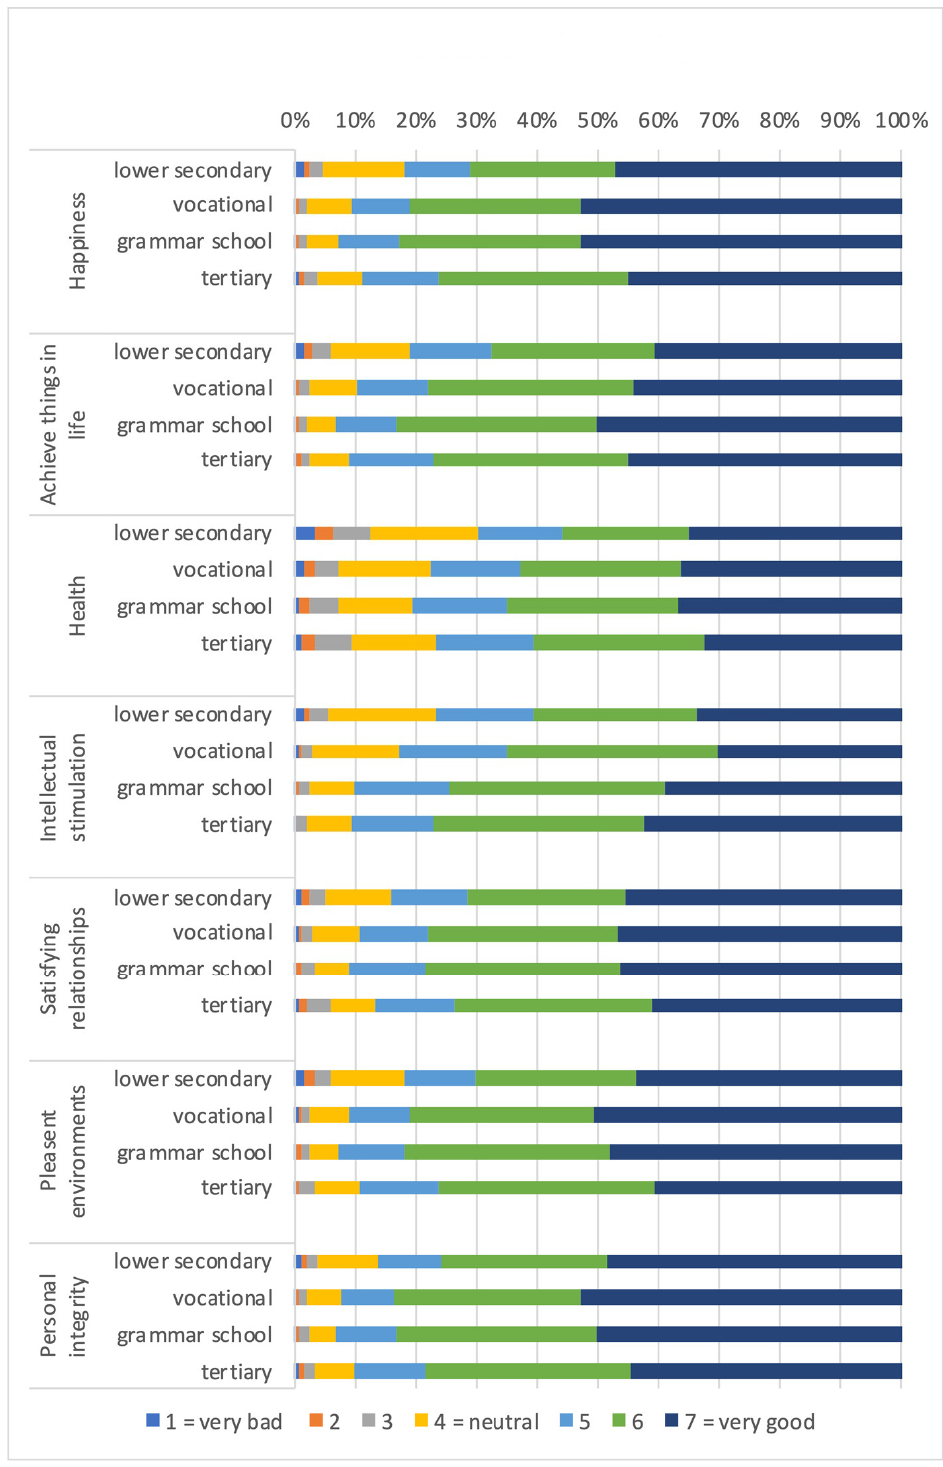
Figure 1. Distribution of capabilities and functionings according to cultural capital (own academic track). ( a ): Distribution of capabilities; ( b ): Distribution of